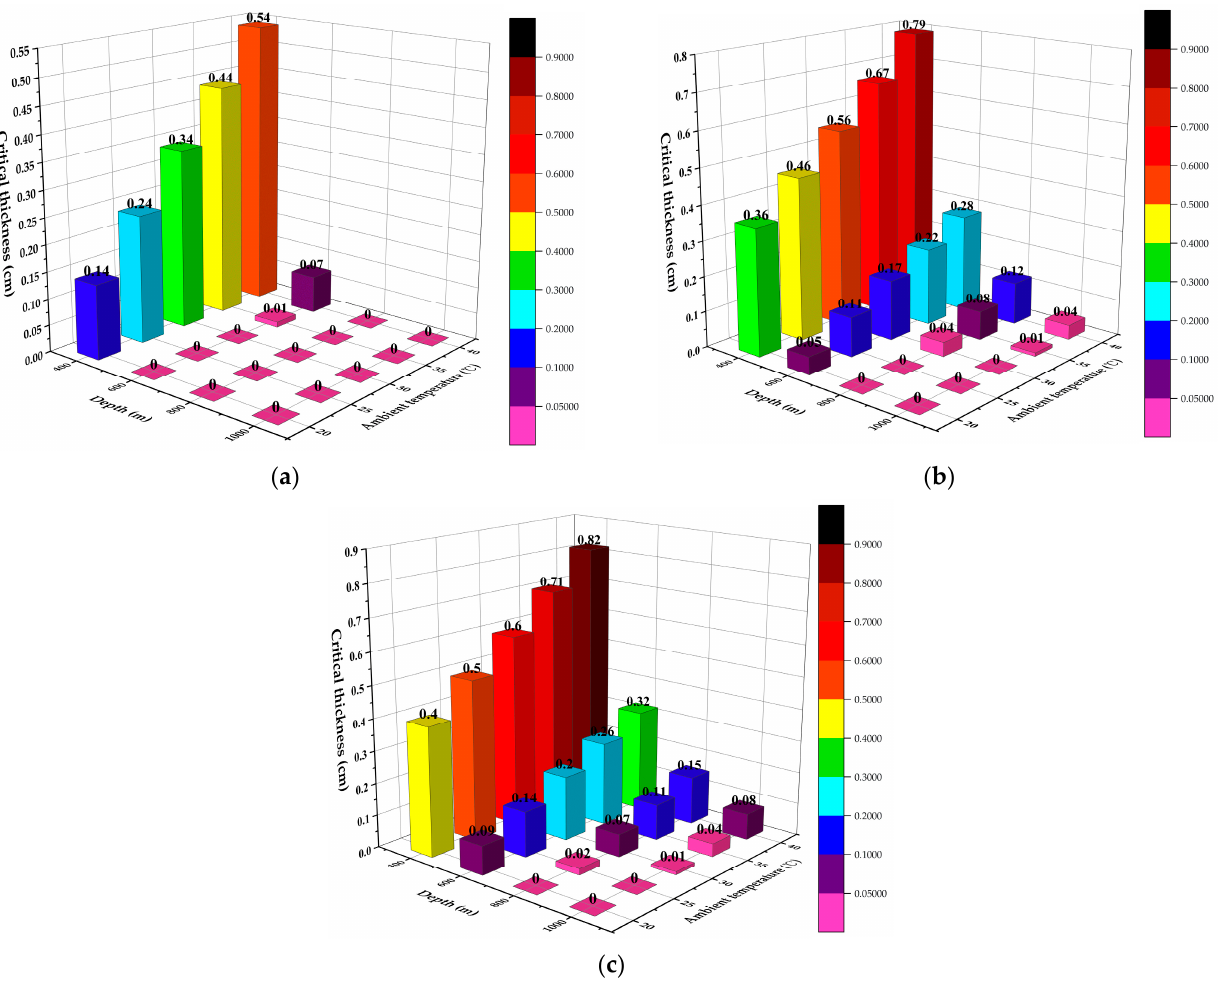
Figure 13. Influences of the depth and the ambient temperature on the critical insulation thickness at different airflow velocities (( a ) 1 m/s; ( b ) 7.5 m/s; ( c ) 15 m/s). different airflow velocities (( a ) 1 m/s; ( b ) 7.5 m/s; ( c ) 15